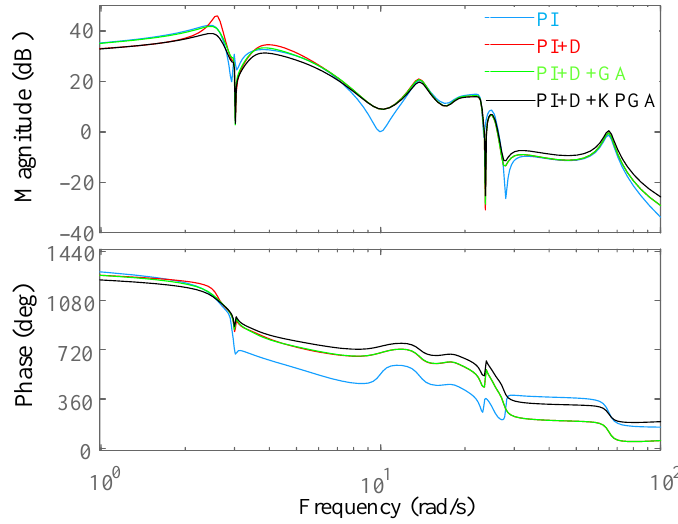
Figure 9. The pitch system Bode plot.